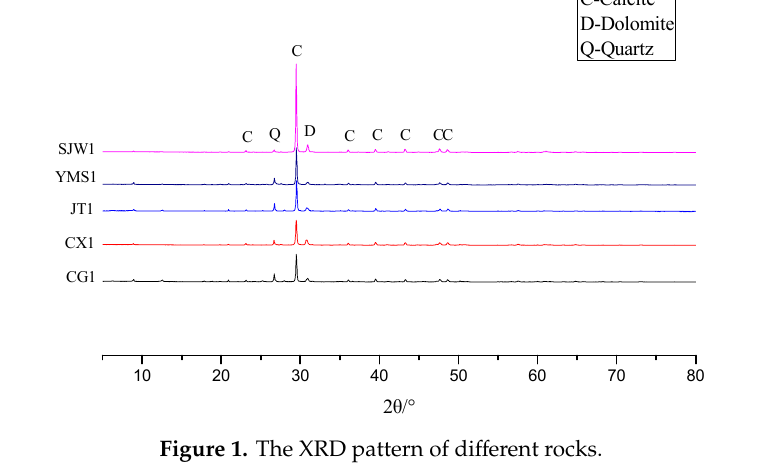
Figure 1. The XRD pattern of different rocks. Table 1. Rock chemical compositions.